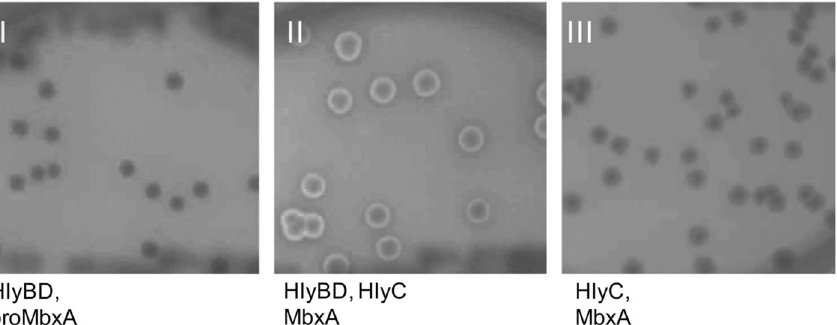
Figure 2. E. coli BL21(DE3) grown on Columbia agar with 5% sheep blood harboring the plasmids pK184- hlyBD with pSU- 6H-mbxA (I), pK184- hlyBD with pSU- hlyC / 6H-mbxA (II) or pSU- hlyC/6H-mbxA alone (III). Halo formation around colonies that expressed MbxA and HlyC together with the transporter components HlyBD (II) and absence of hemolysis around colonies that express only MbxA and HlyC (III) indicates functional secretion of active and acylated MbxA. Thus functional MbxA is not released from E. coli without additional expression of the HlyBD secretion system.